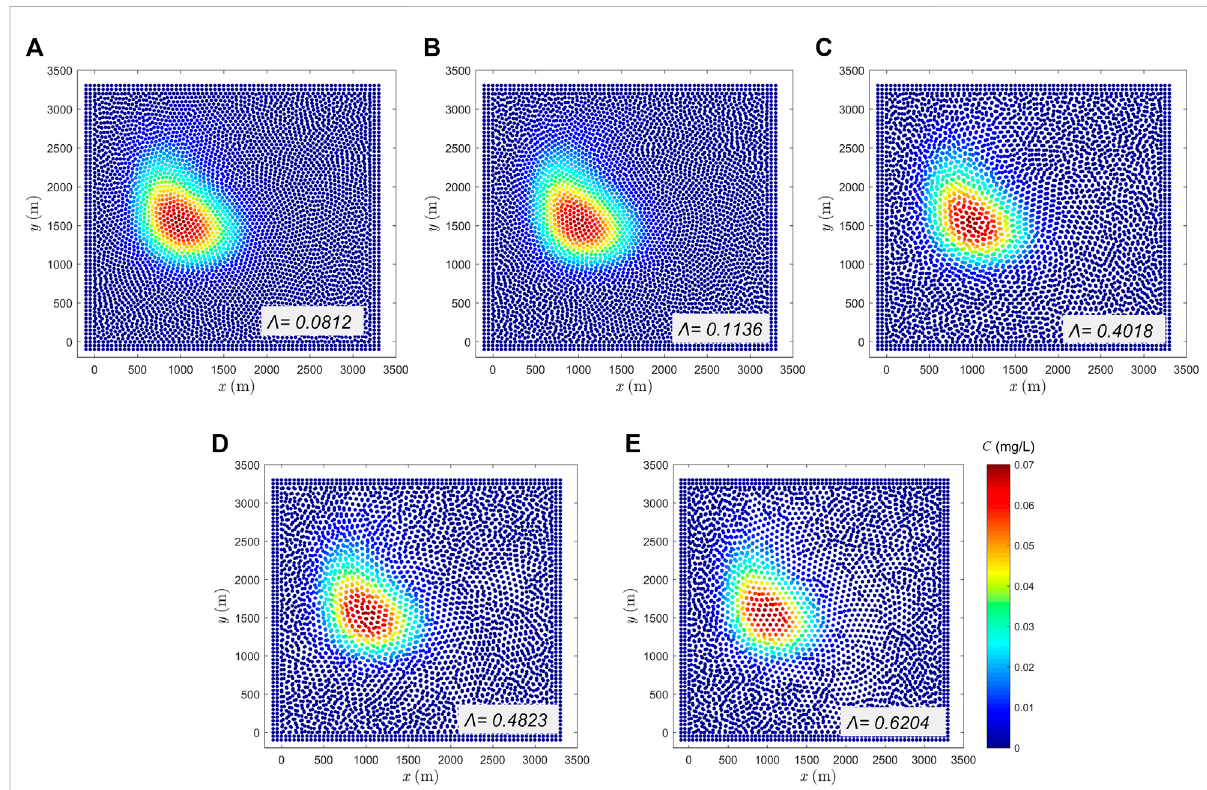
FIGURE 7 Simulation results for one rotation by Lind ’ s PST with cubic spline kernel without RF in different smoothing length. (A) h = 1.1 dx , (B) h = 1.2 dx , (C) h = 1.33 dx , (D) h = 1.4 dx and (E) h = 1.5 dx